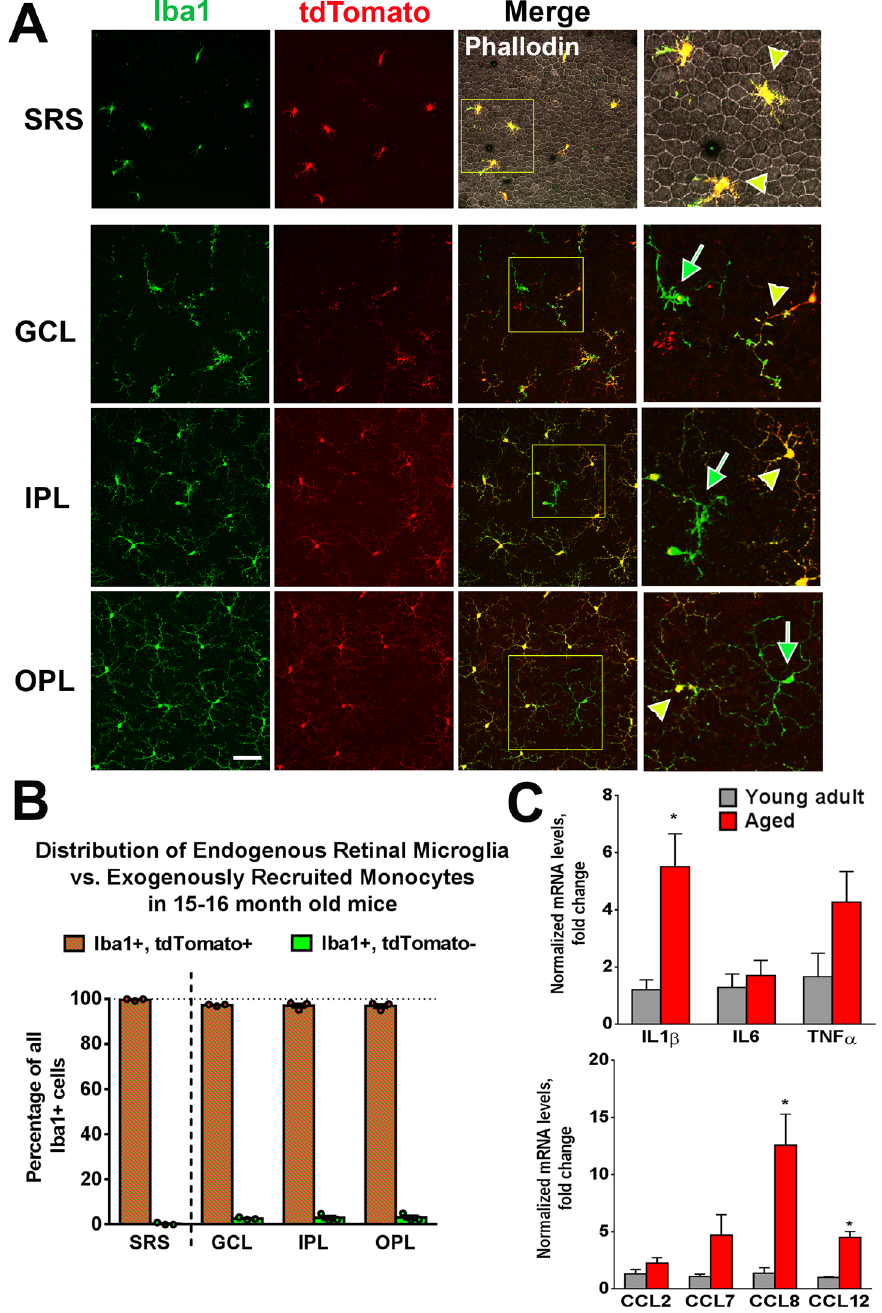
Figure 7. Microglia mobilization and monocyte recruitment during aging in the mouse retina. ( A ) Cre-tdT mice were administered tamoxifen at 2 months of age to enable “cell-fate” mapping of retinal microglia vs. systemic monocytes, and then allowed to undergo normal aging under standard conditions in the absence of injury until analysis at 15–16 months of age. ( Top row ) Analysis in sclerochoroidal-RPE flat-mounts demonstrated the presence of Iba1 + myeloid cells in the subretinal space (SRS) on the apical surface of RPE cells (labeled with phalloidin). All Iba1 + cells in the SRS were almost entirely tdTomato + ( yellow arrowheads ), indicating that they had arisen from endogenous microglia. ( Lower rows ) Iba1 + cells in the inner layers (GCL, IPL, OPL) were predominantly tdTomato + ( yellow arrowheads ); however a very small ( < 5%) minority of Iba1 + cells was tdTomato-negative ( green arrows ), indicating their origin from infiltrating monocytes. Scale bar = 100 µ m. ( B ) Quantification of Iba1 + , tdTomato + cells (from endogenous microglia) and Iba1 + , tdTomato- cells (from infiltrating monocytes) in all retinal lamina, demonstrating very low levels of contribution of exogenous monocytes to the resident population of retinal myeloid cells. ( C ) Comparison of mRNA levels of inflammatory cytokines and CCR2 ligands as measured by qRT- PCR between retinas from young adult (2 months old) and aged adult (24 months old) mice. Column heights and error bars show mean ± SEM; * indicates p < 0.05; Mann-Whitney test, n = 3–5 independent replicates per